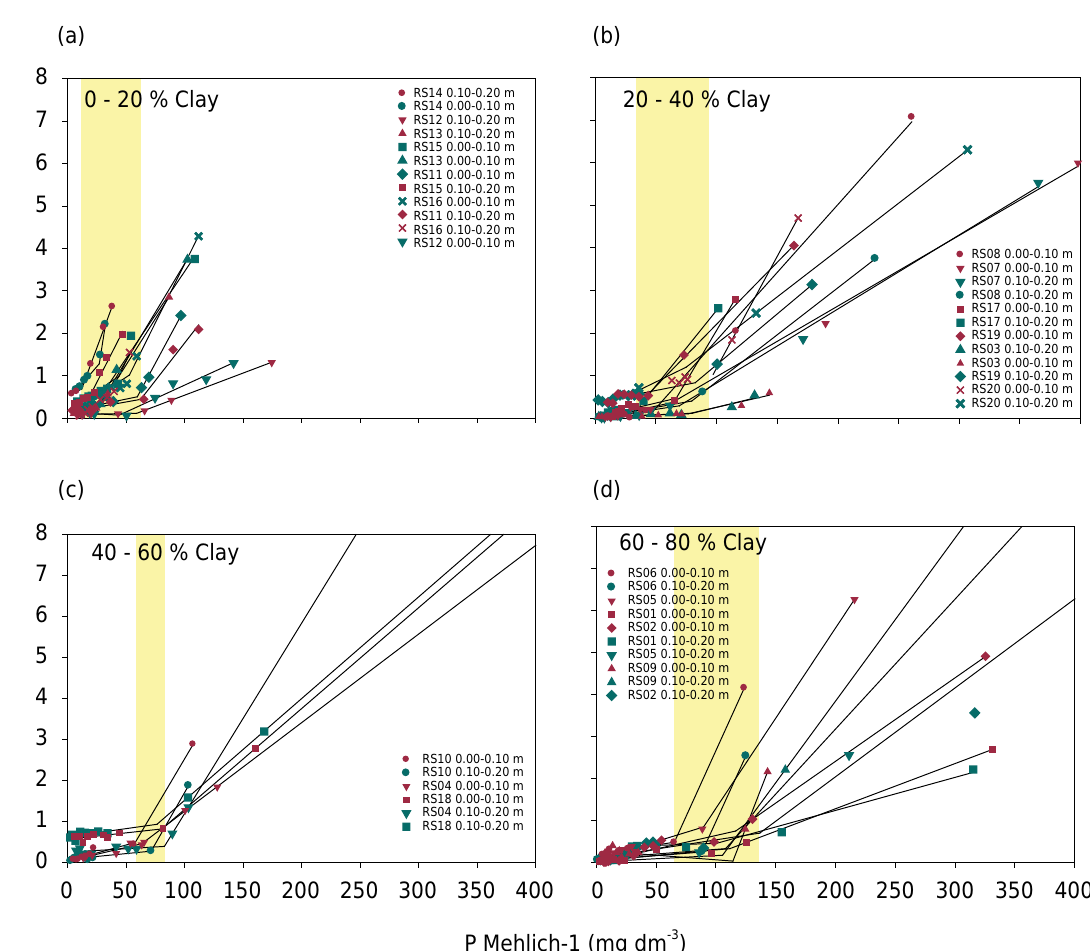
Figure 3. Relation between P-Mehlich-1 and P-water for the 40 samples of soils collected in the state of Rio Grande do Sul, Brazil. The graphics a, b, c, and d represent the range of 0-20 (a), 21-40 (b), 41-60 (c) and 61-80 % (d) of clay, respectively. Red symbols refer to the layer of 0.00-0.10 m, whilst green symbols refer to the layer of 0.10-0.20 m. The yellow stripe represents the amplitude of values of P-thresholds.